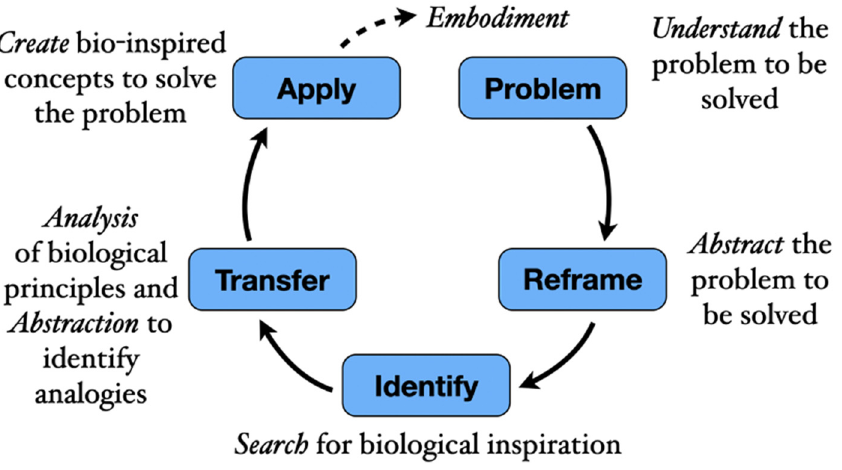
Figure 1. Fundamental BID process. Soap-/oil-/dressing-/sauce-dispensing devices are convenient and popular but have many drawbacks: pumping mechanisms are difficult to clean, require high pumping force to move viscous fluids, and include many small parts and a difficult assembly. Nozzles can easily become clogged with viscous or grainy fluids. The volume of dispensing is fixed or hard to adjust. Redesign a soap-/oil-/dressing-/sauce-dispensing device to address one, some, or all of the above